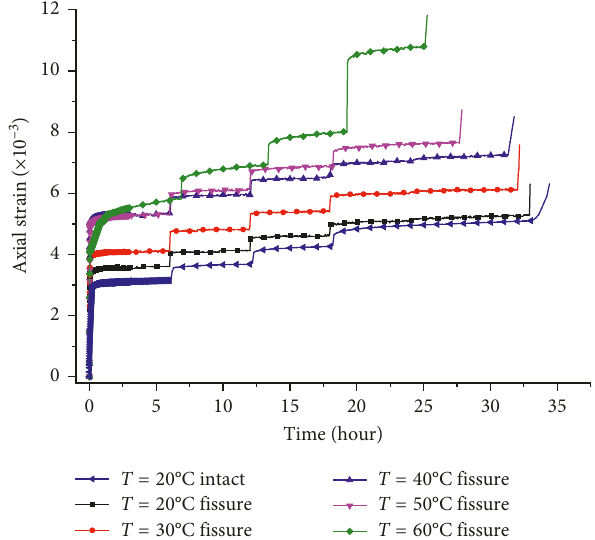
Figure 6: Strain-time curves obtained from uniaxial multistage creep experiments for the shale-like material under different temperatures (T).